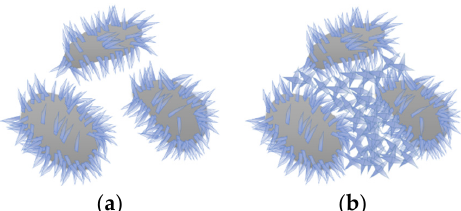
Figure 1. The formation of the C-S-H phase in the cement pastes: ( a ) without the nanoadmixture (NA); ( b ) using the NA with the C-S-H seeds.